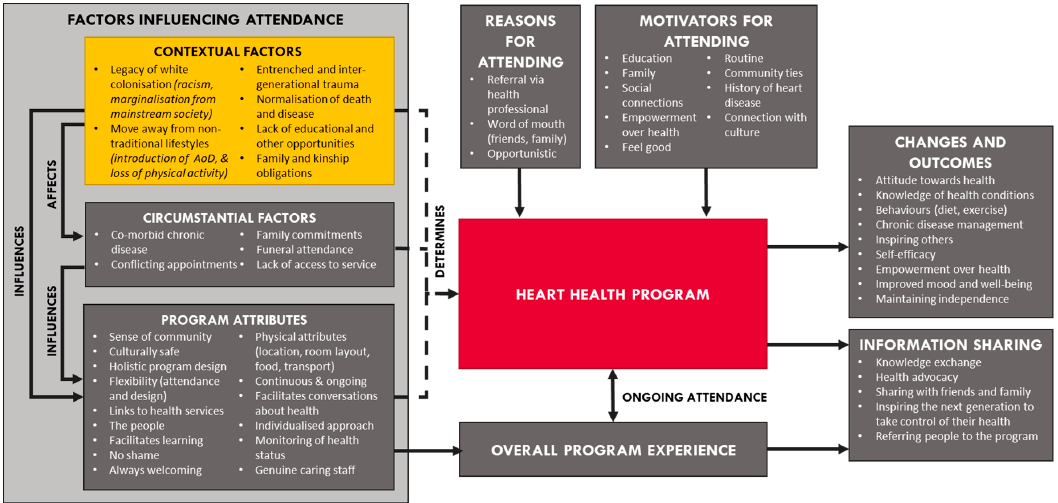
Figure 1. Factors influencing Heart Health program attendance and associated outcomes.